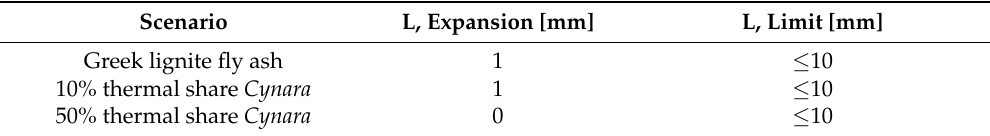
Table 8. Soundness testing results for some fly